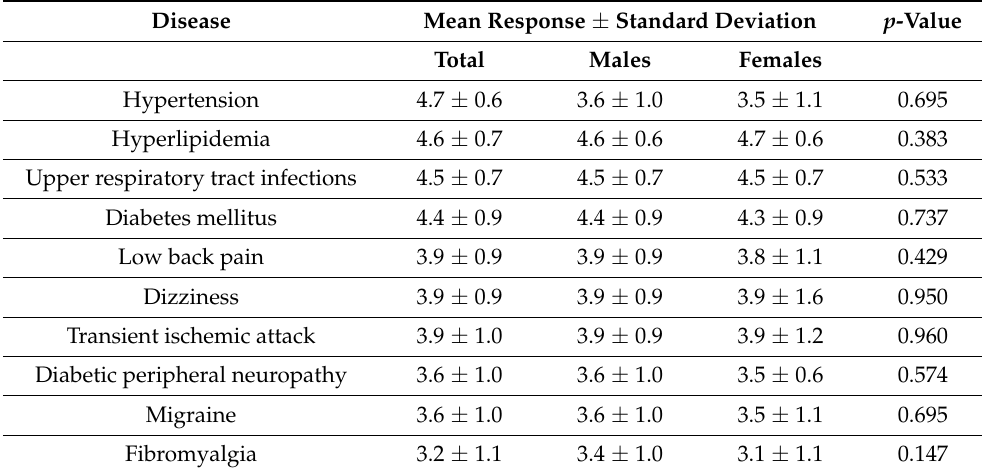
Table 3. Responses to diseases/symptoms, ranked by